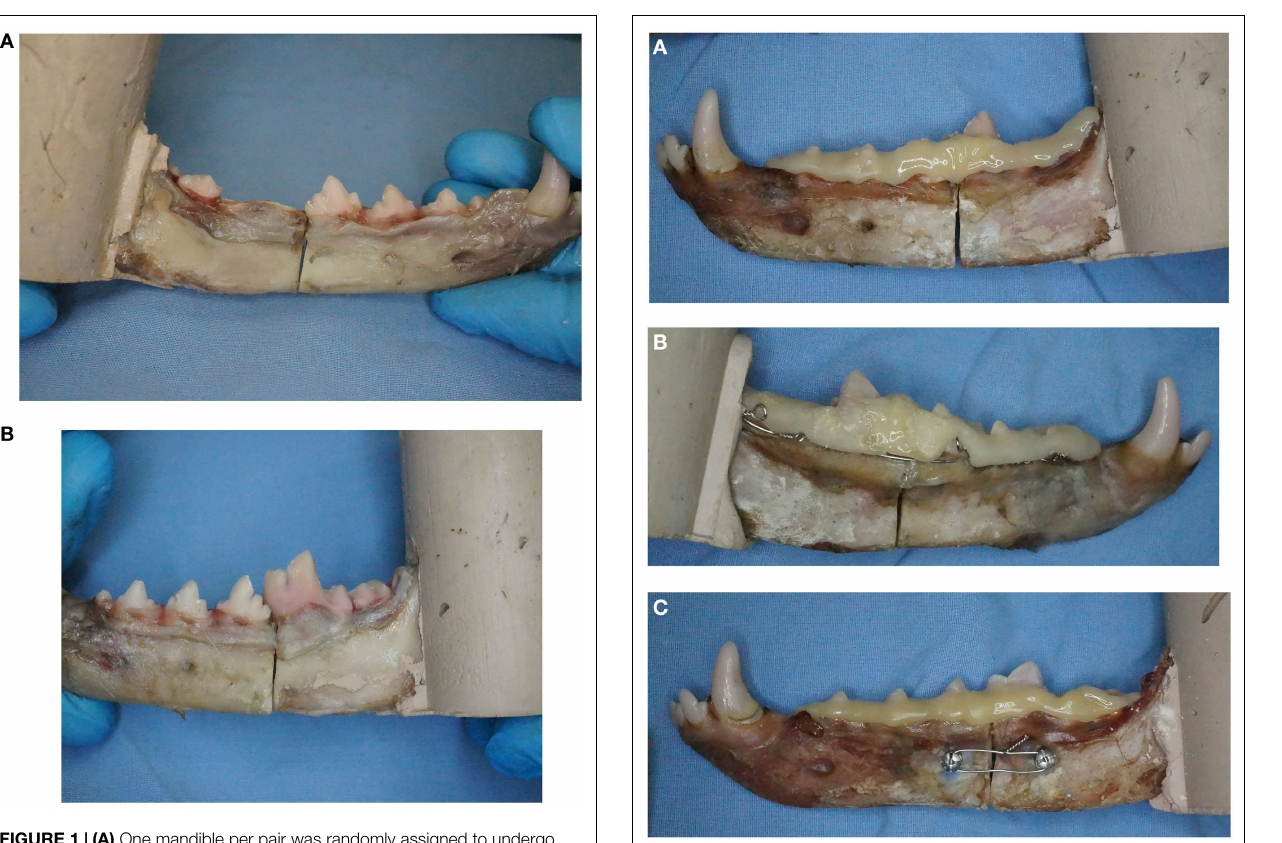
FIGURE 2 | Examples of the three fracture repair techniques applied to specimens with intact first molar crowns . Specimens demonstrating (A) composite only (CO), (B) interdental wiring and composite (IWC), and (C) transmucosal screw and composite (TSC) are